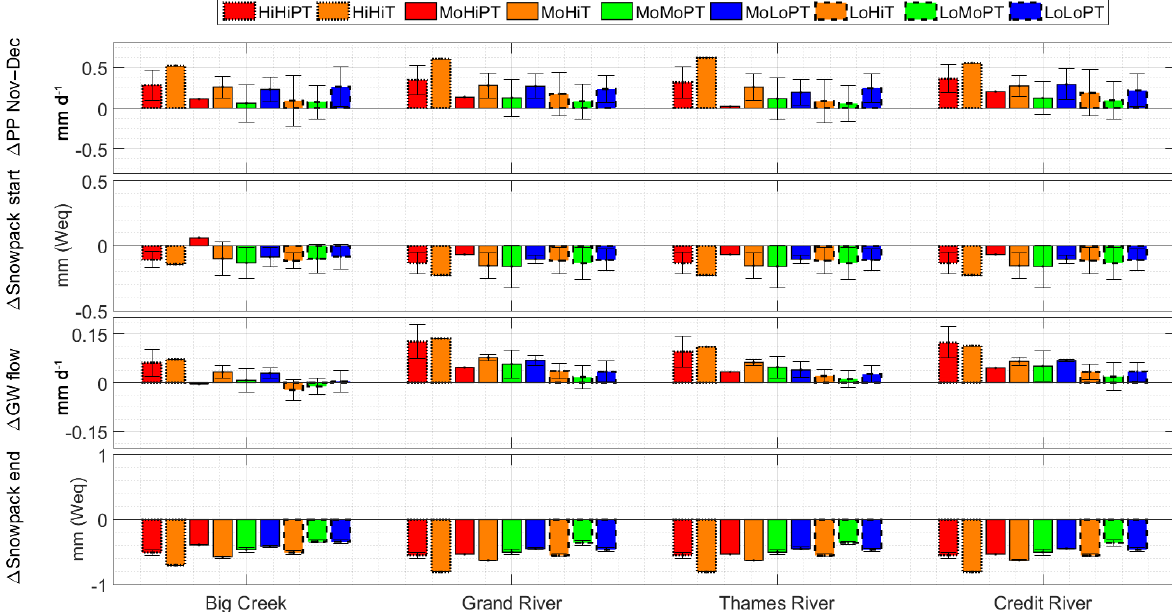
Figure 10. Class average (bars) and standard deviation (hatches) of the change between the historical and the 2040s periods of precipita- tion amount (mm) in November–December, snowpack amount (mm water equivalent – Weq) on 25 December, groundwater (GW) flow in January–February and snowpack amount (mm water equivalent – Weq) on 23